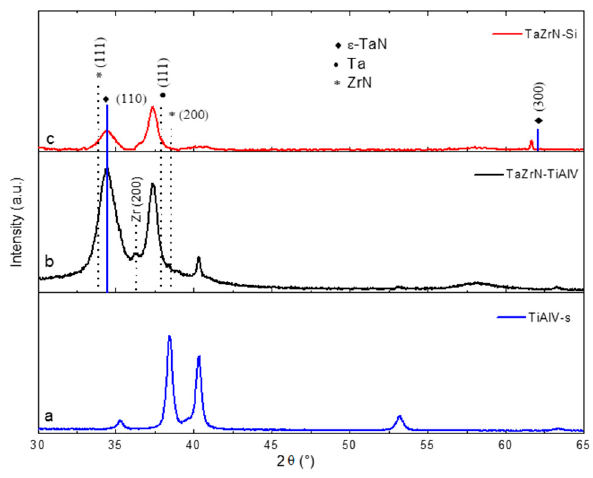
Figure 2. Diffractograms of coatings and substrates: ( a ) TiAlV substrate; ( b ) TaZrN on TiAlV substrate; and ( c ) TaZrN on Si substrate.